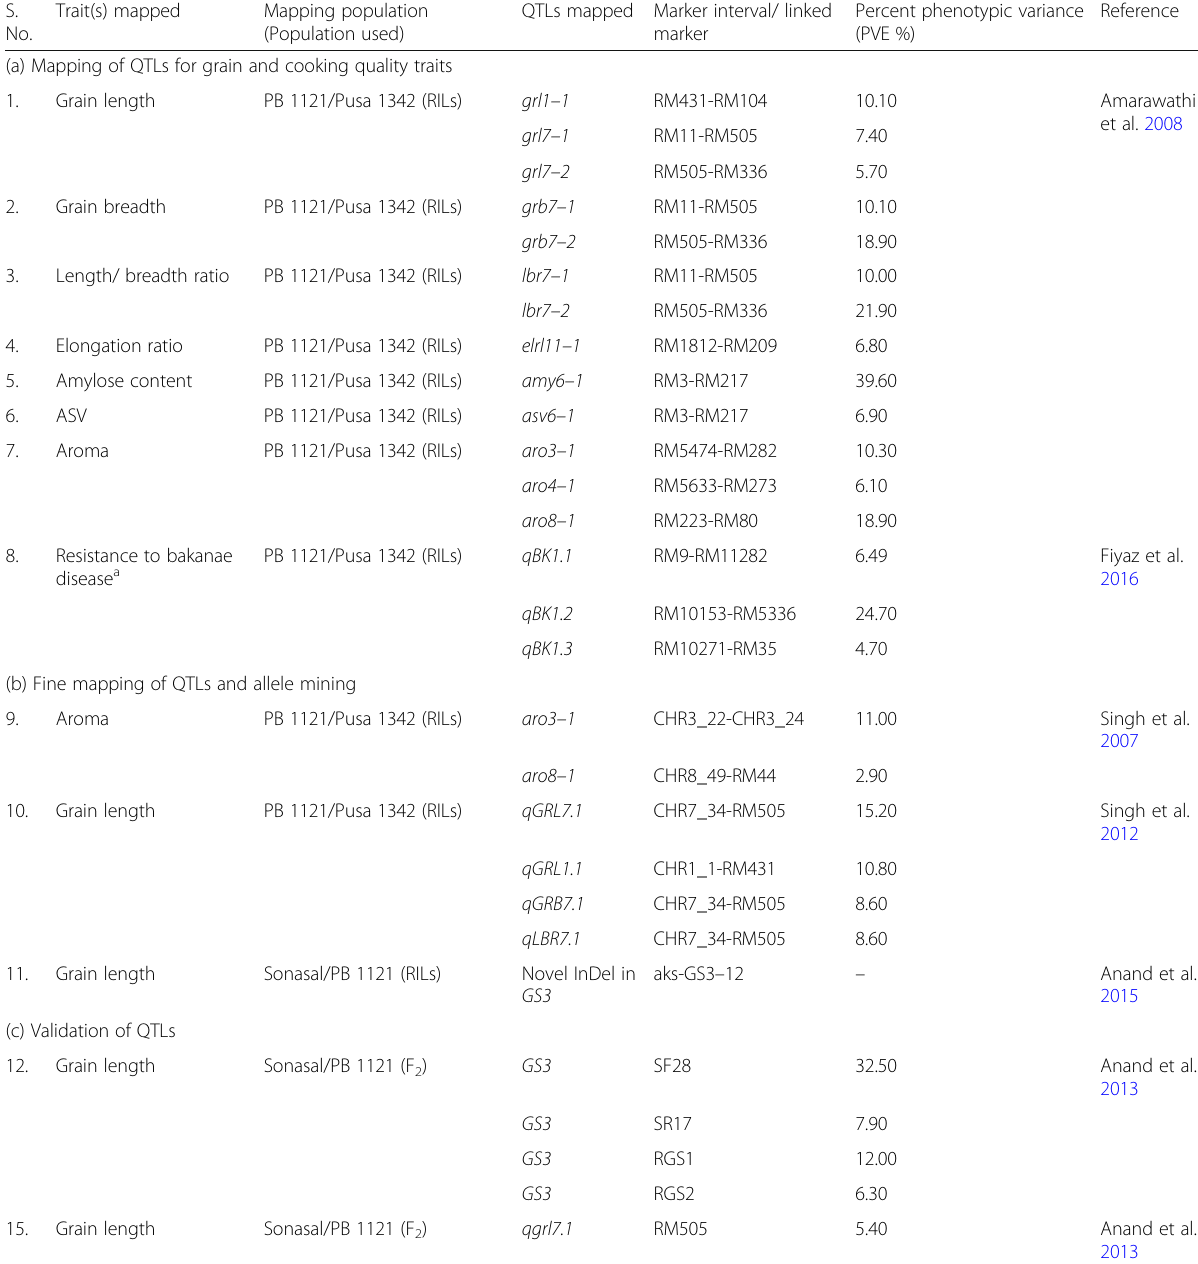
Table 2 Mapping populations developed using PB 1121 for mapping and validation of QTLs governing various traits in rice S. Trait(s) No.